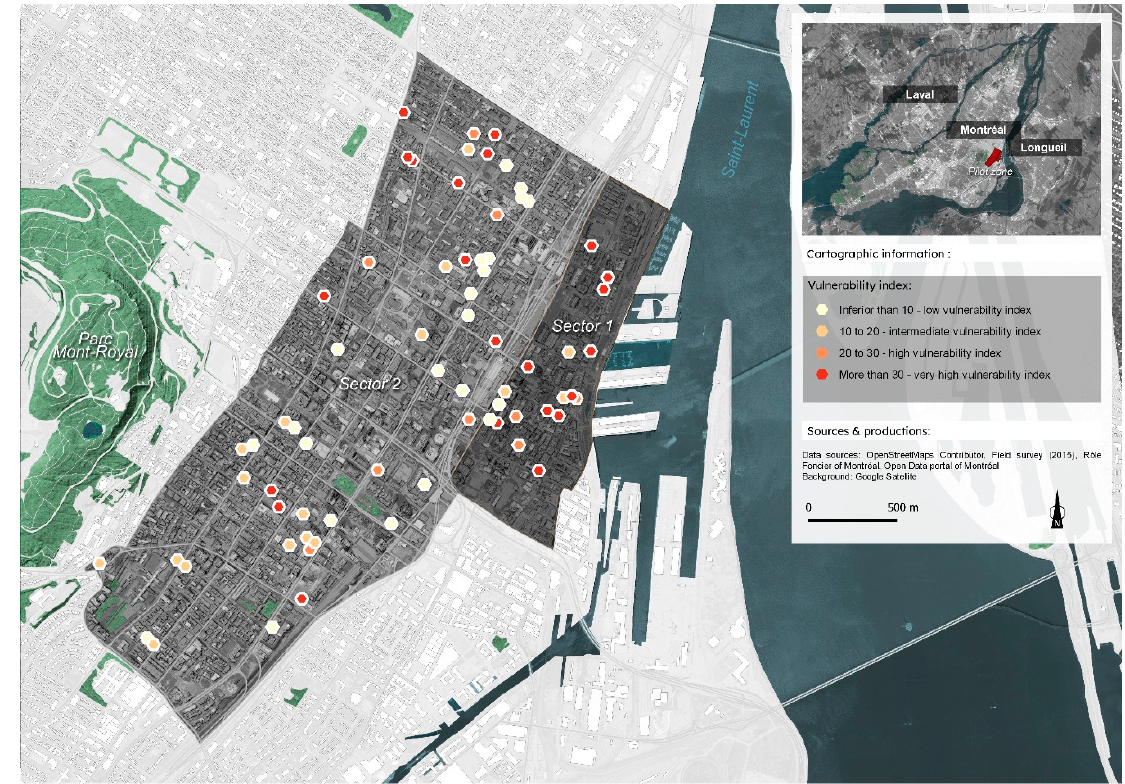
Figure 8. Vulnerability index of the selected buildings in the pilot zone.